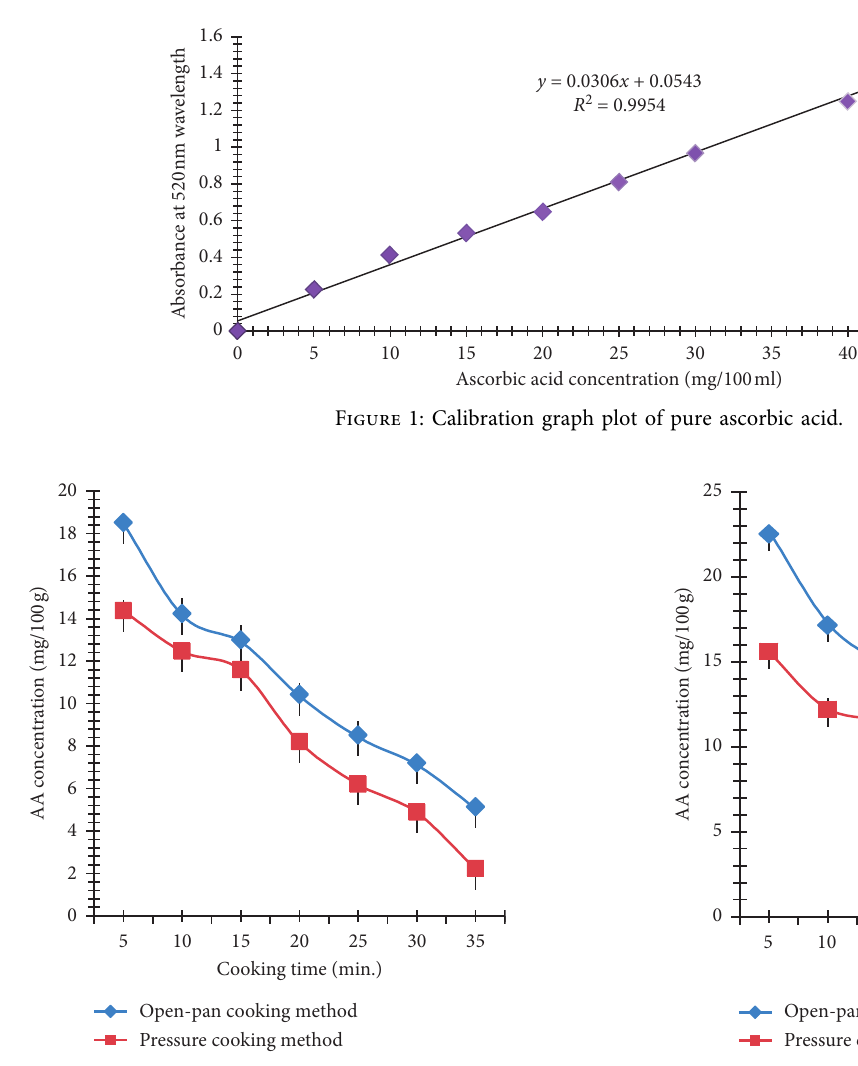
Figure 3: Effect of cooking methods on ascorbic acid loss of Ethiopian green collard (error bars represent SE of the